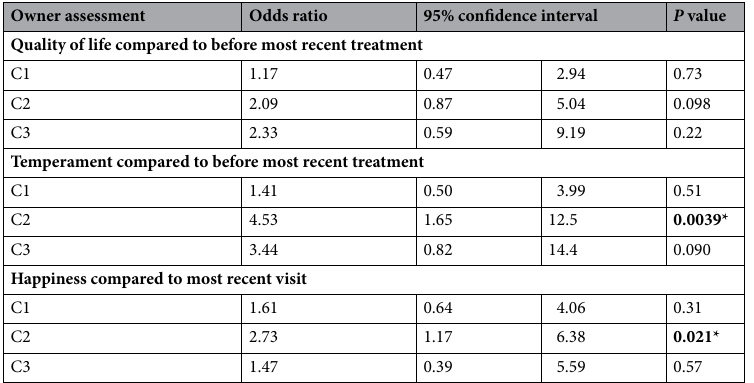
Table 7. Results of owner-based assessments of quality of life (QoL), temperament, and happiness. The odds ratios show the effect of robenacoxib relative to placebo. C1 contrast 1 = treatment group PP compared against groups RR and RP following 3 weeks of treatment, C2 contrast 2 = treatment group PP compared against group RR following 6 weeks of treatment, C3 contrast 3 = treatment group RP compared against RR for change in activity between weeks 3 and 6 of treatment. The tests are effectively comparing the categorical response probability distributions. An odds ratio greater than 1 indicates a higher likelihood of better outcomes for